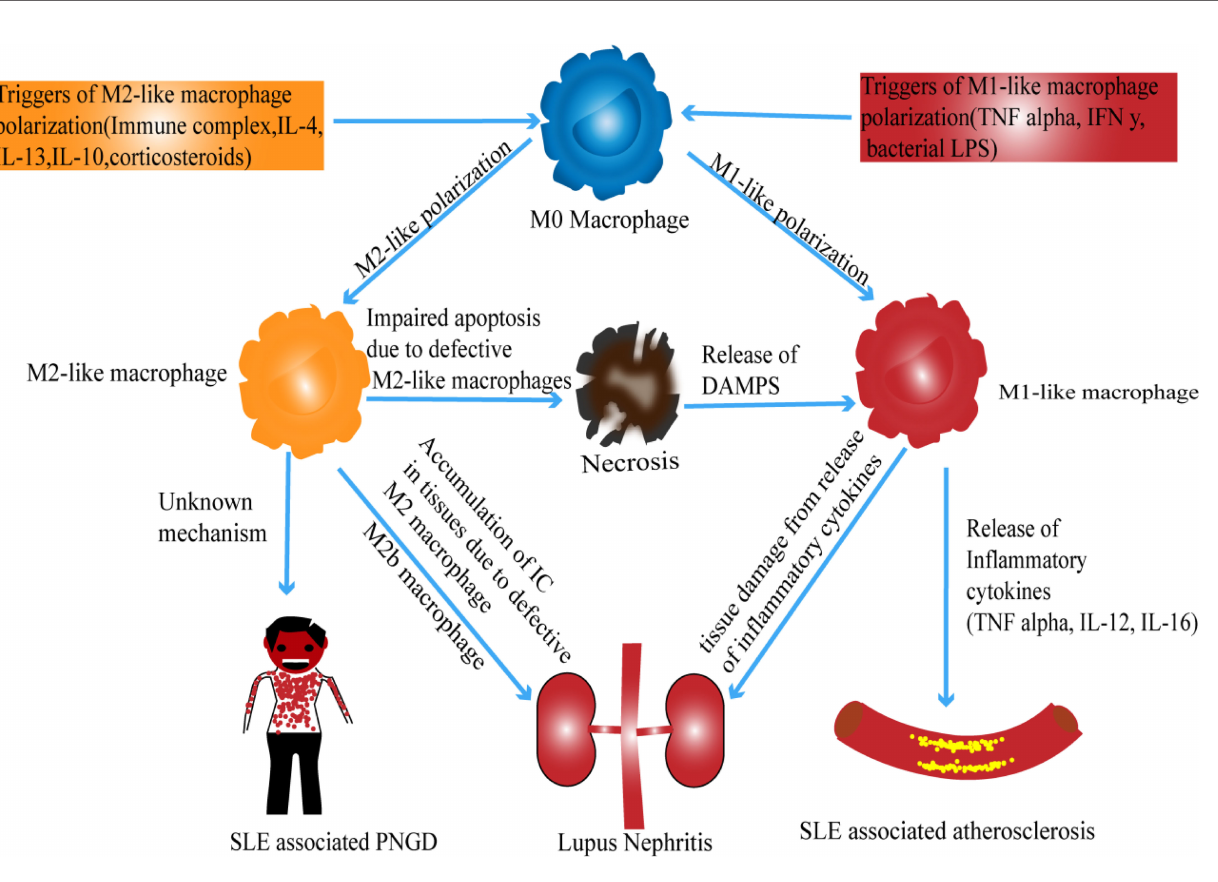
FIGURE 1 | Possible mechanism of macrophage polarization in